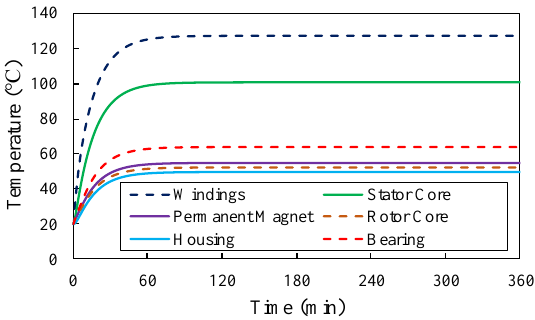
( c ) Figure 18. YASA machine assembly: ( a ) stator; ( b ) rotor; ( c ) machine assembly. 5.2. Prototype Experiment